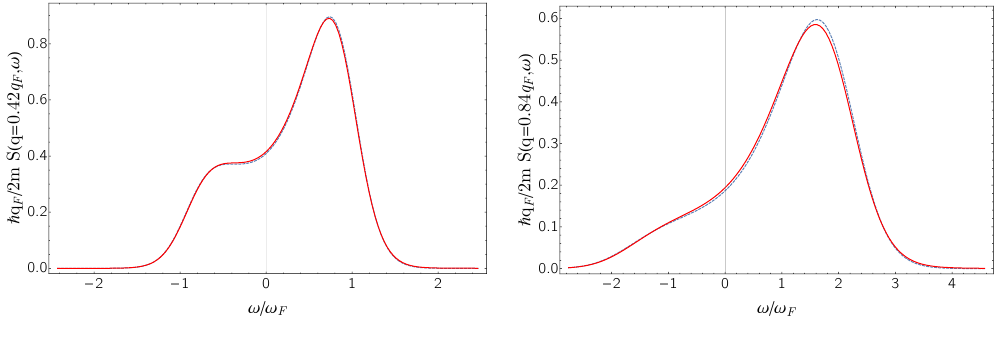
Figure 6: S ( q , ω ) (red) and S ( 1 ) ( q , ω ) (blue, dotted) as functions of ω for q = 0.42 q (left panel) and q = 0.84 q (right panel). The parameters are the same as in Figure F